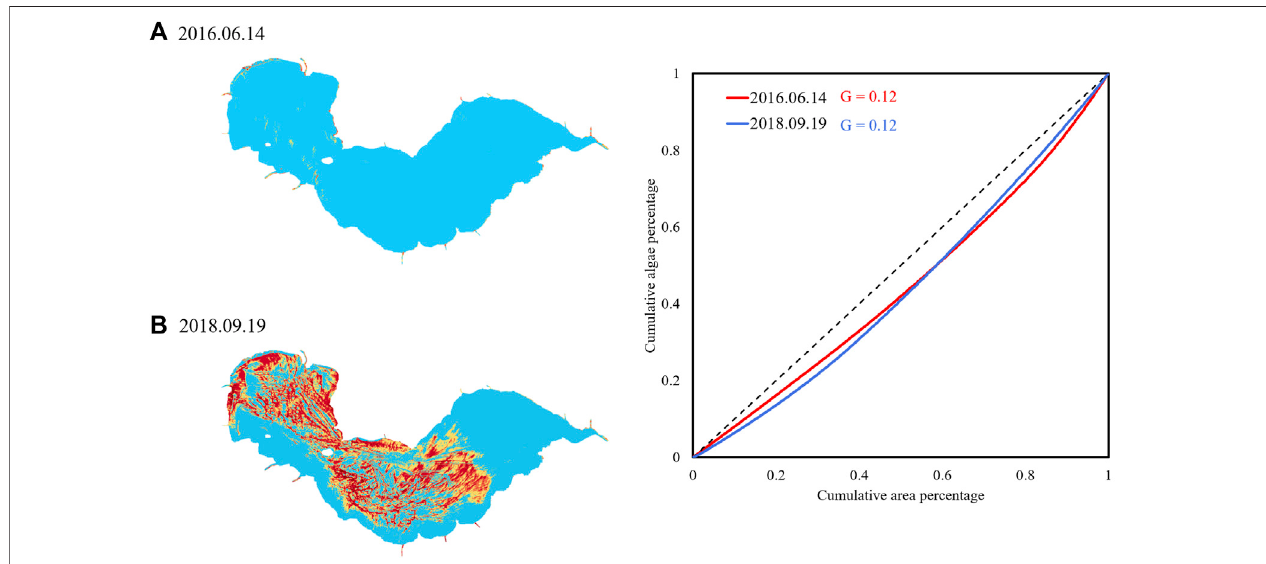
FIGURE 5 | Example of images with the same G but different algal bloom distribution and Lorenz curve.